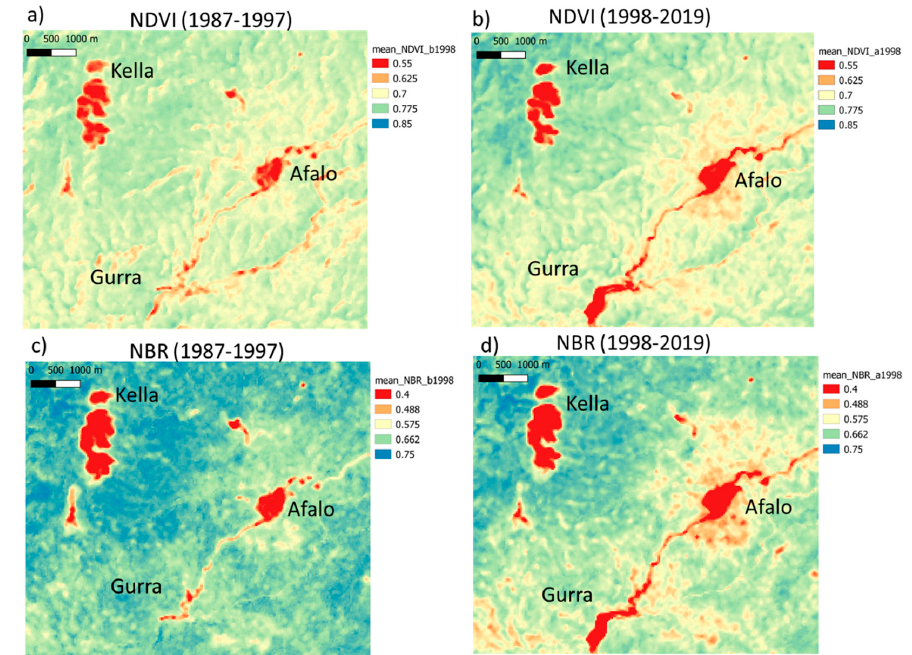
Figure 10. Composite (mean) maps for NDVI and NBR for two different periods. ( a ) and ( b ) are the NDVI composite maps for the period of 1987–1997 and 1999–2019, respectively. ( c ) and ( d ) are the NBR composite maps for the period of 1987–1997 and 1998–2019, respectively. The range of NDVI in the composite map is scaled from 0.55 to 0.85, and the range of NBR from 0.4 to 0.75. Dark red areas are settlements, roads and rivers, and light red areas are potentially HMCF.